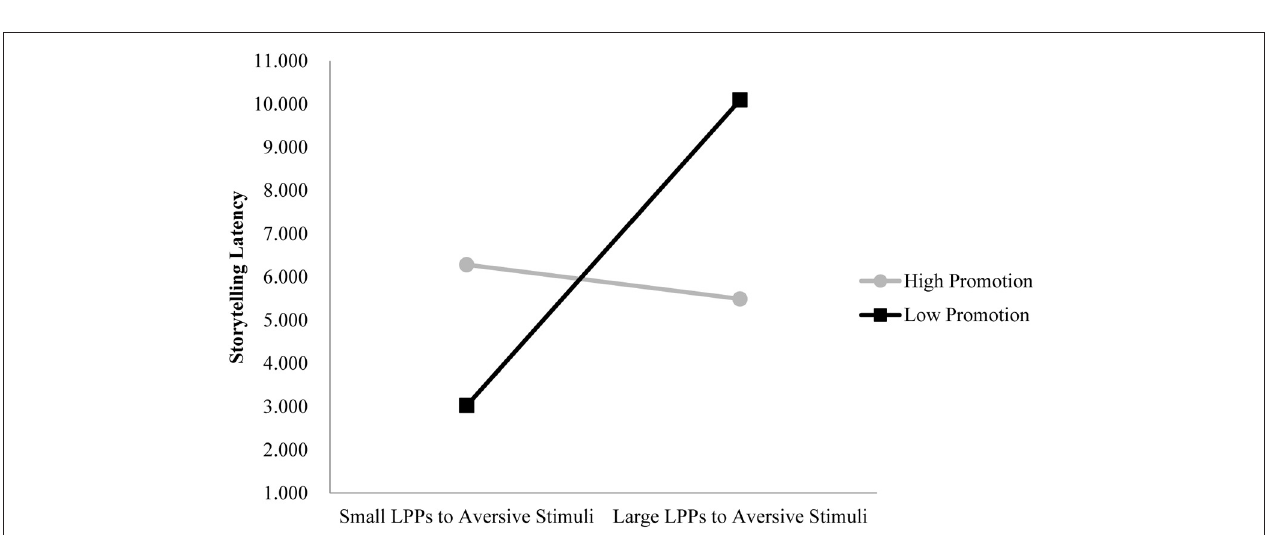
FIGURE 4 | LPPs to aversive stimuli interact with promotion parenting to predict inhibited behavior during the black box task. Note : Longer latencies indicate more inhibited behavior. LPPs are quantified as the difference between LPP amplitudes to aversive minus LPPs to neutral